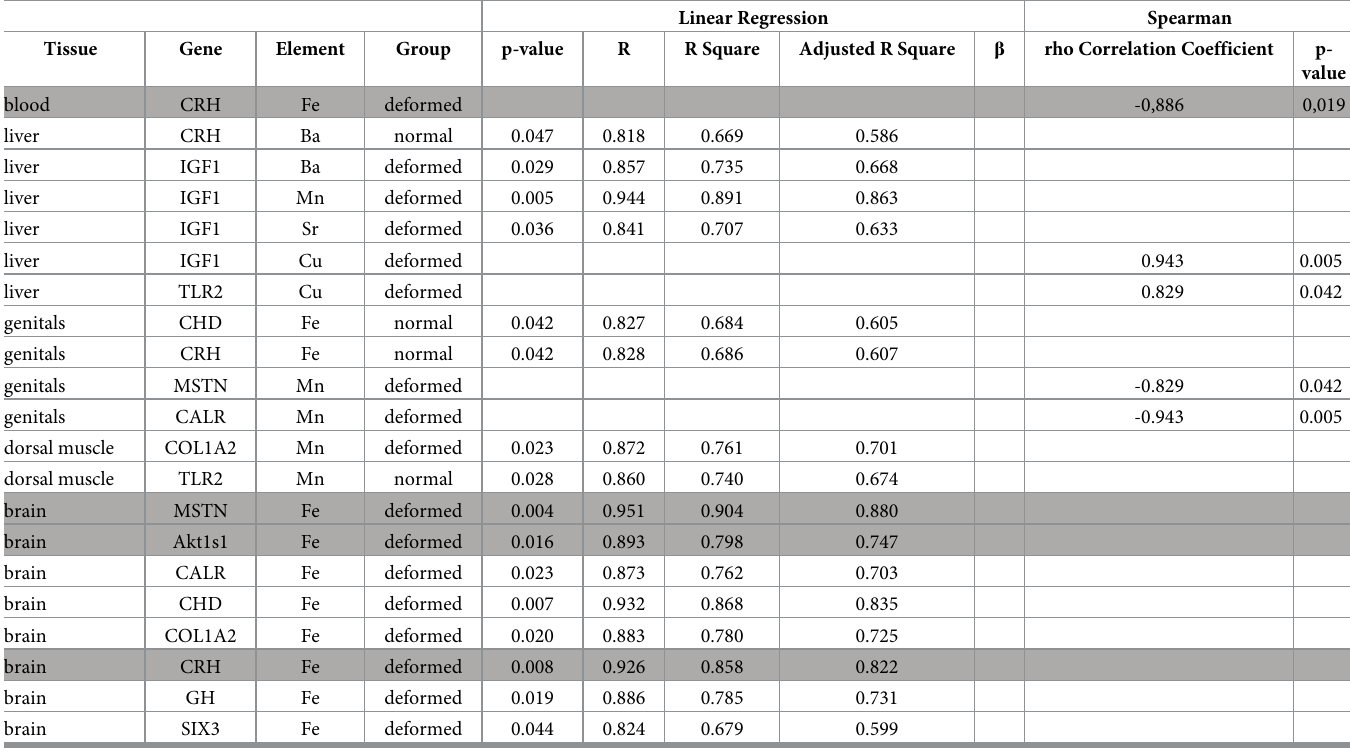
Table 4. The result of significant correlations between mRNA levels and spinal microelement contents based on linear regression and Spearman’s correlation test. Linear Regression